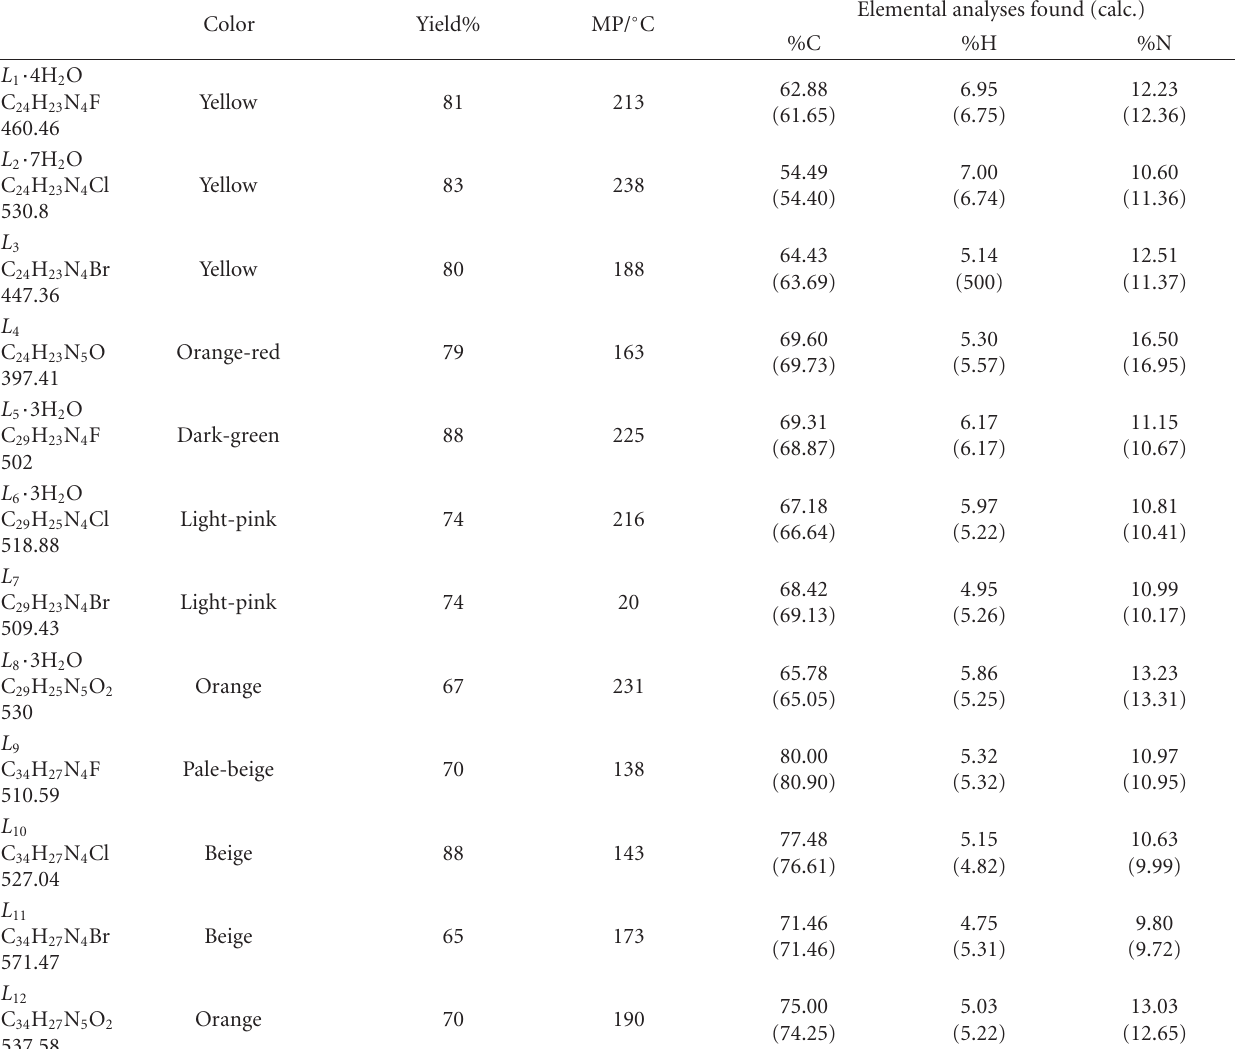
Table 1: Physical properties and elemental analyses of the ligands.